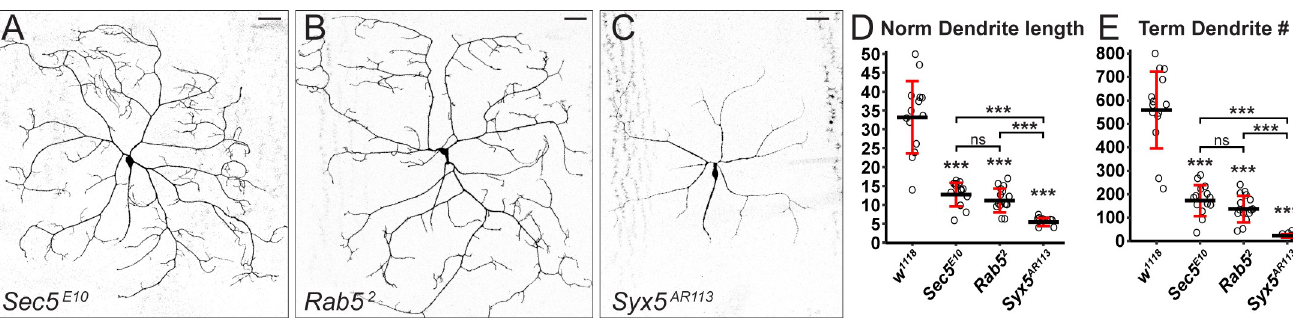
Fig 4. Mosaic analysis of example genes in neuronal dendrite development. (A–C) MAGIC clones of C4da neurons mutant for Sec5 E10 (A), Rab5 2 (B), and Syx5 AR113 (C), visualized by ppk > MApHS . Scale bars, 50 μ m. (D and E) Quantification of normalized dendrite length (total dendrite length/segment width) (D) and terminal branch number (E) of C4da clones of wild-type control ( w 1118 ) and mutants. n = number neurons: w 1118 ( n = 14); Sec5 E10 ( n = 14); Rab5 2 ( n = 15); Syx5 AR113 ( n = 10). The asterisk above each genotype indicates comparison with the control. ��� p � 0.001, ns, not significant, Welch ANOVA and Welch t tests, p -values corrected using the Bonferroni method. The data underlying this Figure can be found in S1 Data. MAGIC, mosaic analysis by gRNA-induced crossing-over.